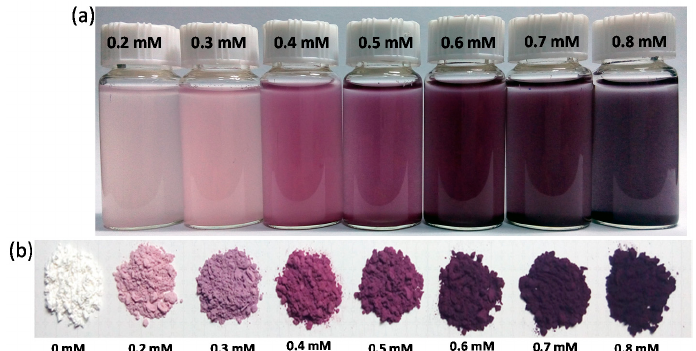
Figure 1. Photographs of ( a ) AuNP-WP solutions and ( b ) corresponding dry WPs for different concentrations of Au ions (0.2–0.8 mM).